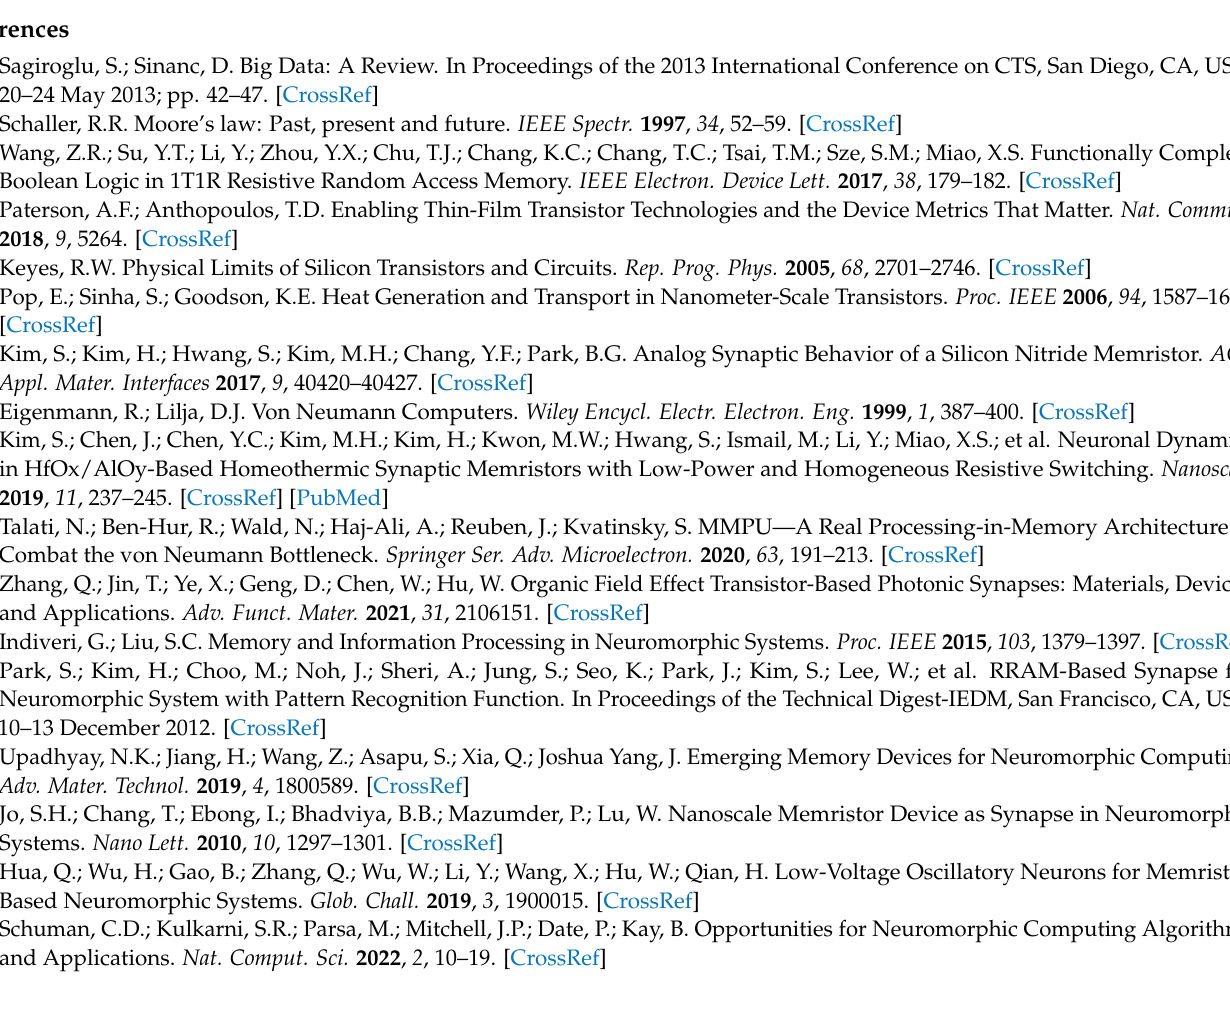
Figure S2. Dependency of current characteristics on channel dimension in the double-layer structure; Figure S3. Dependency of current characteristics on channel dimension in the single-layer structure; Figure S4. Learning operations of the ~70-nm synaptic